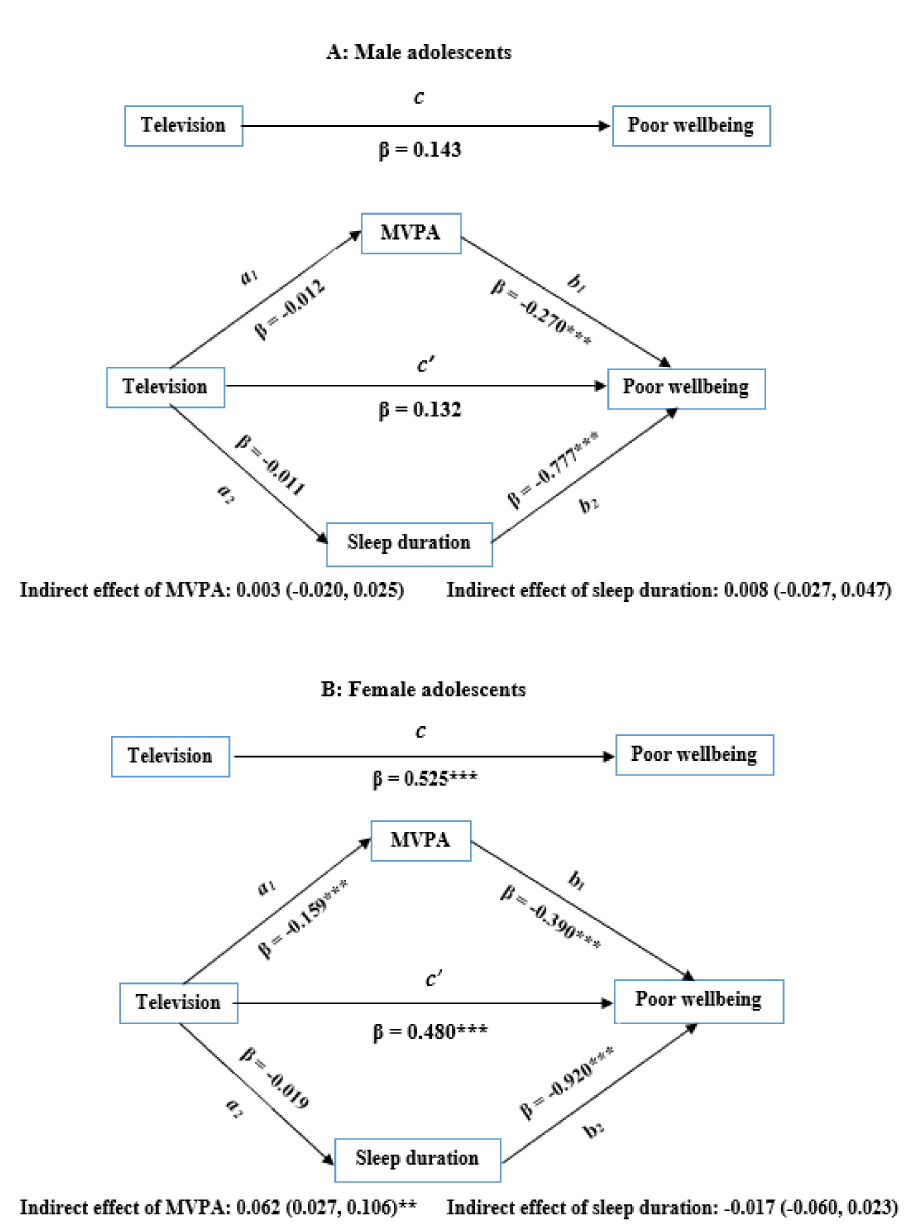
Figure 2. Models of moderate to vigorous physical activity (MVPA) frequency and sleep duration mediating the association between time watching television and psychological wellbeing of ( A ) male and ( B ) female adolescents,